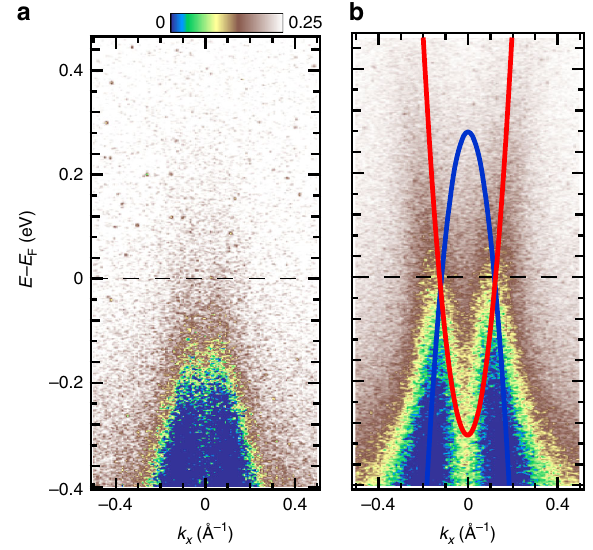
Fig. 4 TARPES spectra of Ta 2 NiSe 5 before and after pumping. a Energy – momentum ( E – k ) map before pumping, integrated in the time interval [ − 0.29, 0] ps. b Corresponding map of the transient states, integrated in [0, 1.2] ps. Red and blue parabolas indicate the electron and hole bands crossing E F in the non-equilibrium metallic state. These spectra were acquired with a pump fl uence of 1.56 mJ cm − 2 . Note that due to the worse energy resolution (~250 meV) compared to the static ARPES measurements shown in Supplementary Fig. 2, the E – k map before pumping seems to have an intensity tail above E F (see also Fig.